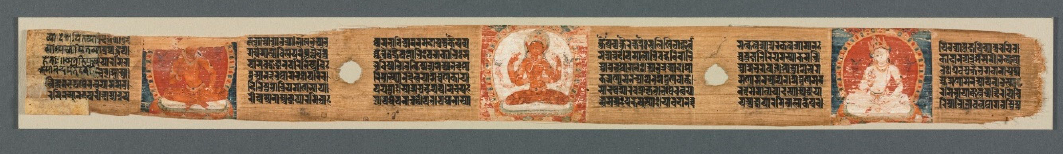
Figure 7. Prajñ ā p ā ramit ā flanked by two bodhisattvas, fol. 187r. Perfection of Wisdom in Eight Thousand Lines: A ṣṭ as ā hasrik ā Prajñ ā p ā ramit ā -s ū tra , 1119. India and Nepal. Gum tempera and ink on palm leaf. 5.3 × 54.3 cm. Cleveland Museum of Art, purchase from the J. H. Wade Fund, 1938.301.5.